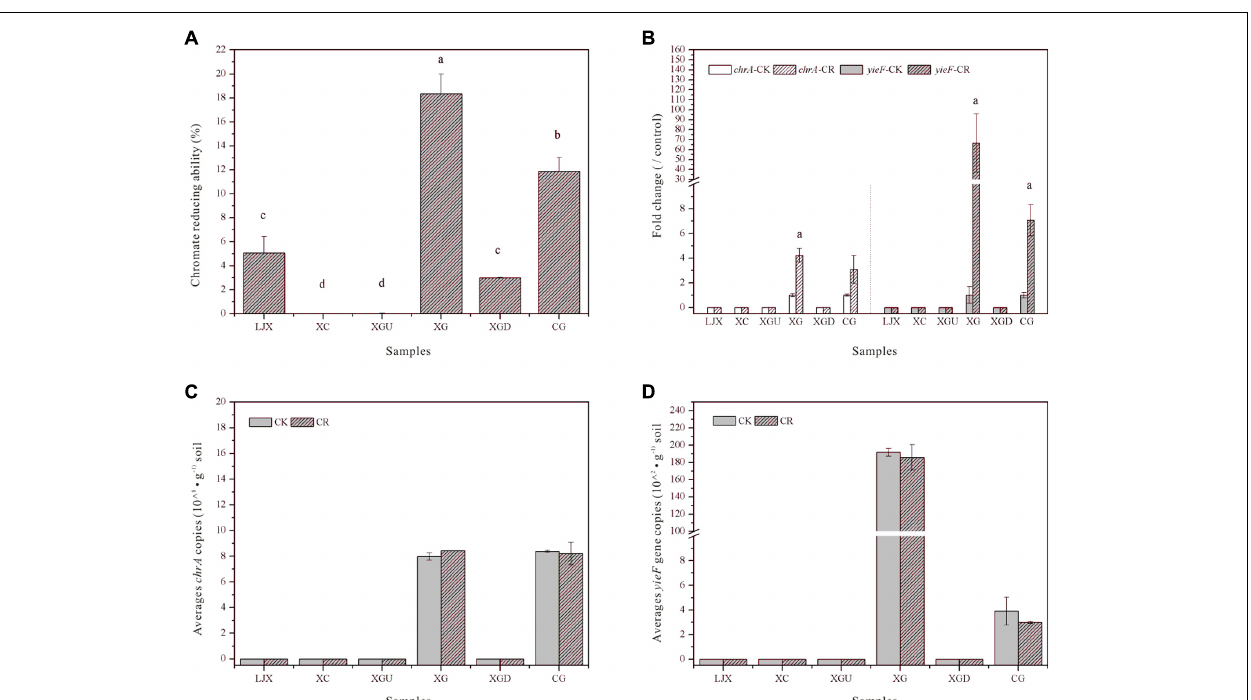
Different sites’ soil samples